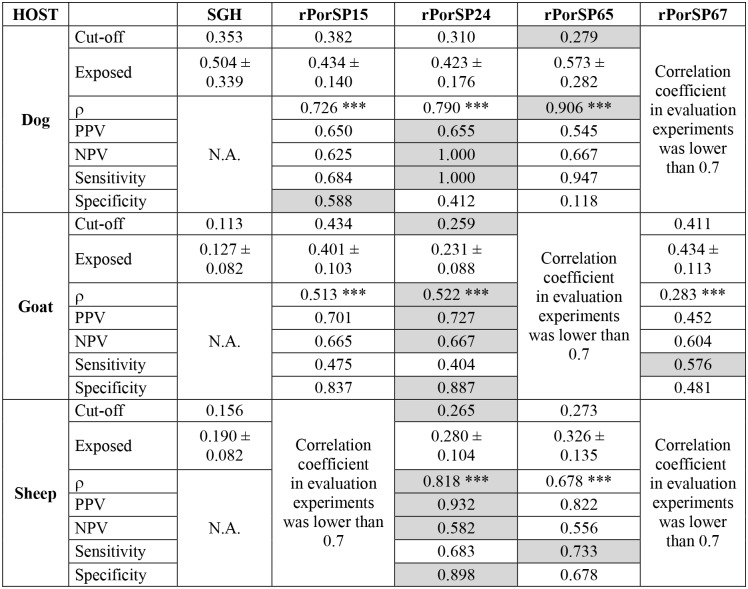
Validation of recombinant proteins.Selected recombinant proteins were validated in ELISA tests with sera of indicated domestic animals naturally-exposed to Phlebotomus orientalis. The analysis was based on comparison with anti-Ph. orientalis SGH IgG as a standard. The table provides cut-off values, mean values of optical density ± standard deviation of IgG levels in animals exposed to Ph. orientalis, correlation coefficients between IgG levels against SGH and a recombinant protein (ρ), positive predictive values (PPV), negative predictive values (NPV), sensitivity, and specificity. Asterisks (*) indicate significant correlations: *p<0.05, **p<0.01, ***p<0.001. Combinations with the correlation coefficient lower than 0.7 in evaluation experiments (Table 2) were excluded from the validation experiments. For each combination, the lowest cut-off value, the highest correlation coefficient, and the highest PPV, NPV, sensitivity, and specificity values are shaded grey. N.A. means not applicable.